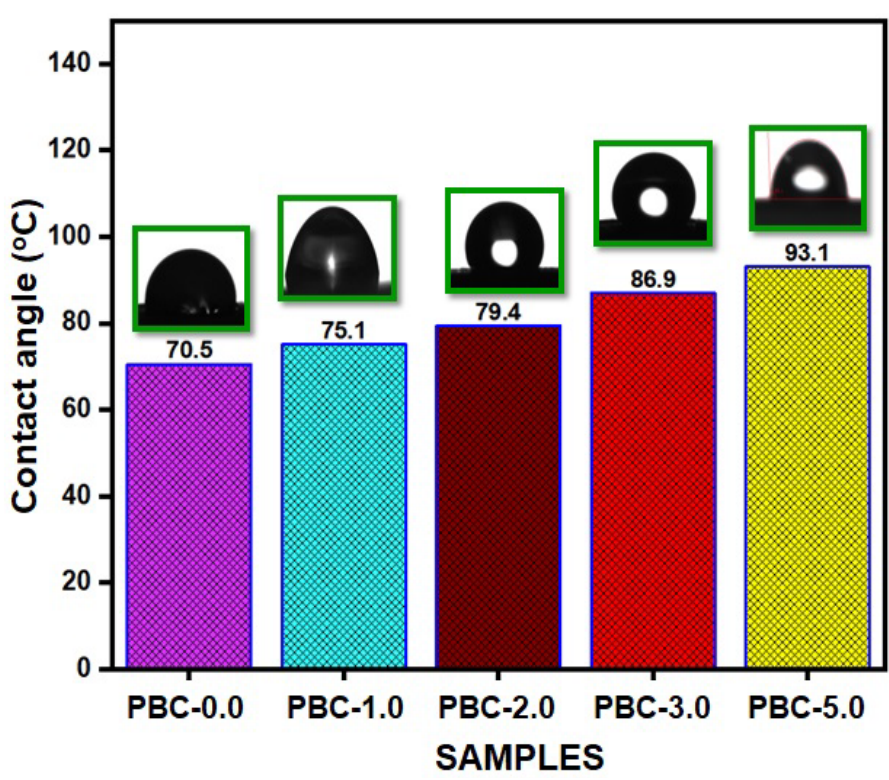
Figure 5. Water contact angle values of PBAT/kaolin biocomposite samples.